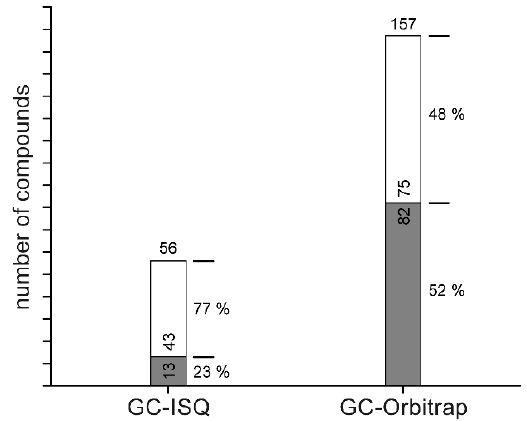
Figure 5. Ratio of compound annotation in each dataset. Samples of a metabolomics experiment were split and measured on both the unit-mass ISQ GC–MS and the Orbitrap GC–MS. Detected compounds were annotated (white) by EI database matching or labeled as unknowns (grey). To ensure no compounds were falsely labeled as unknowns because of low-quality spectra, only spectra with a least 20 deconvoluted fragments were considered.